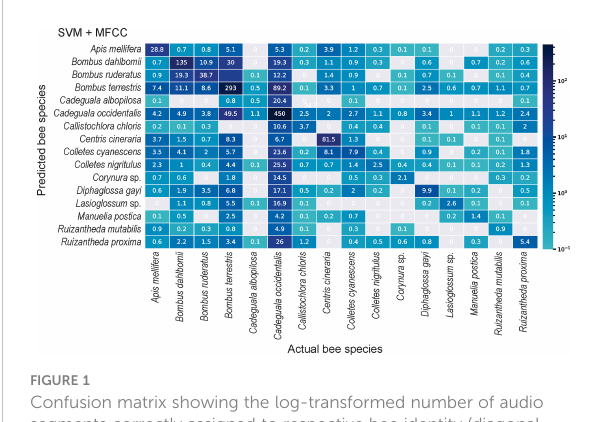
FIGURE 1 Confusion matrix showing the log-transformed number of audio segments correctly assigned to respective bee identity (diagonal elements) versus those erroneously assigned (non-diagonal elements), by the ML classi fi ers. SVM fed by MFCC achieved the best performance among the classical ML algorithms. Cell color represents the corresponding number (log-transformed) of audio segments predicted in a given cell, ranging from gray (zero predicted audio segments) to dark blue.